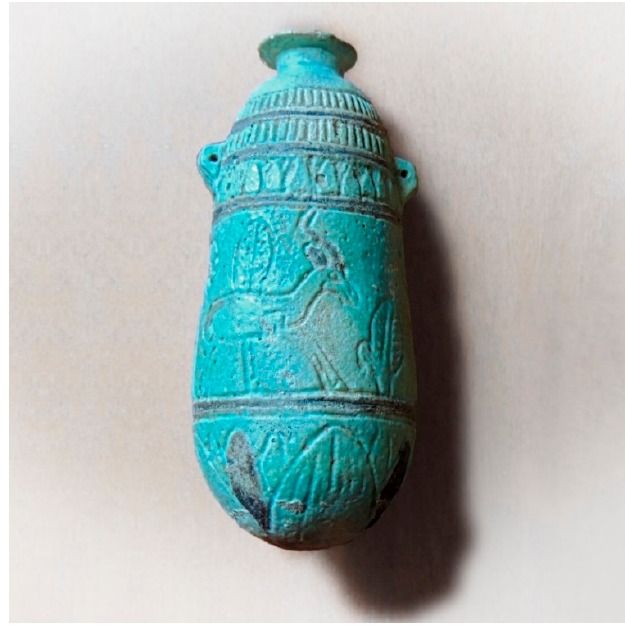
Figure 22. Antelope in landscape (MGW inv. no. 865); faience ointment jar (alabastron); perhaps from Rhodian workshop; ca. mid-7th century BCE .